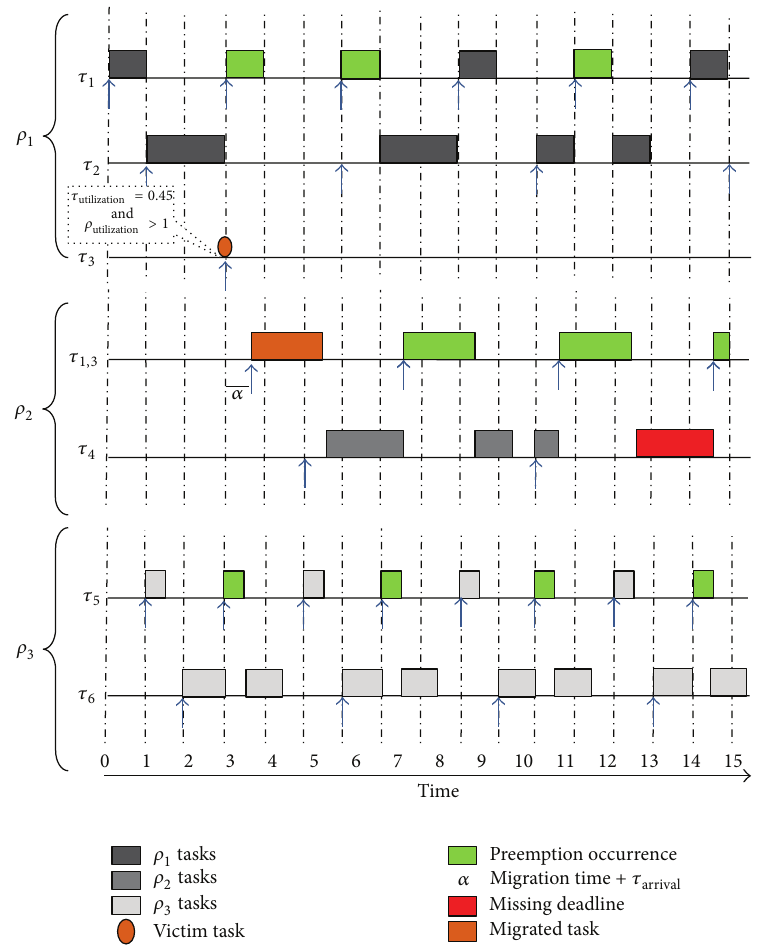
Figure 4: EDF scheduling algorithm in